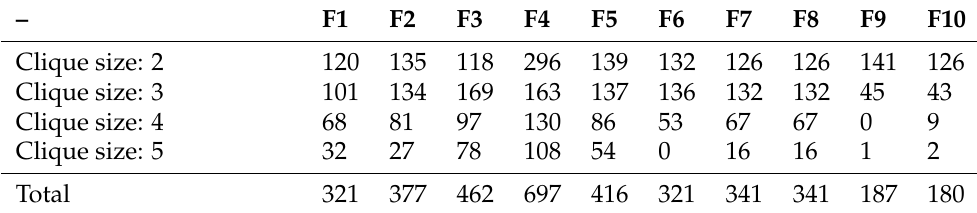
Table 1. The raw result of analyzing the networks constructed from the biomedical publications for clique. The columns show the 10-folds that made up the dataset and the score. The rows show the size of the cliques. The last row shows the total number of cliques detected from each fold. Overall, the total number of all cliques detected from the publication is 3643.